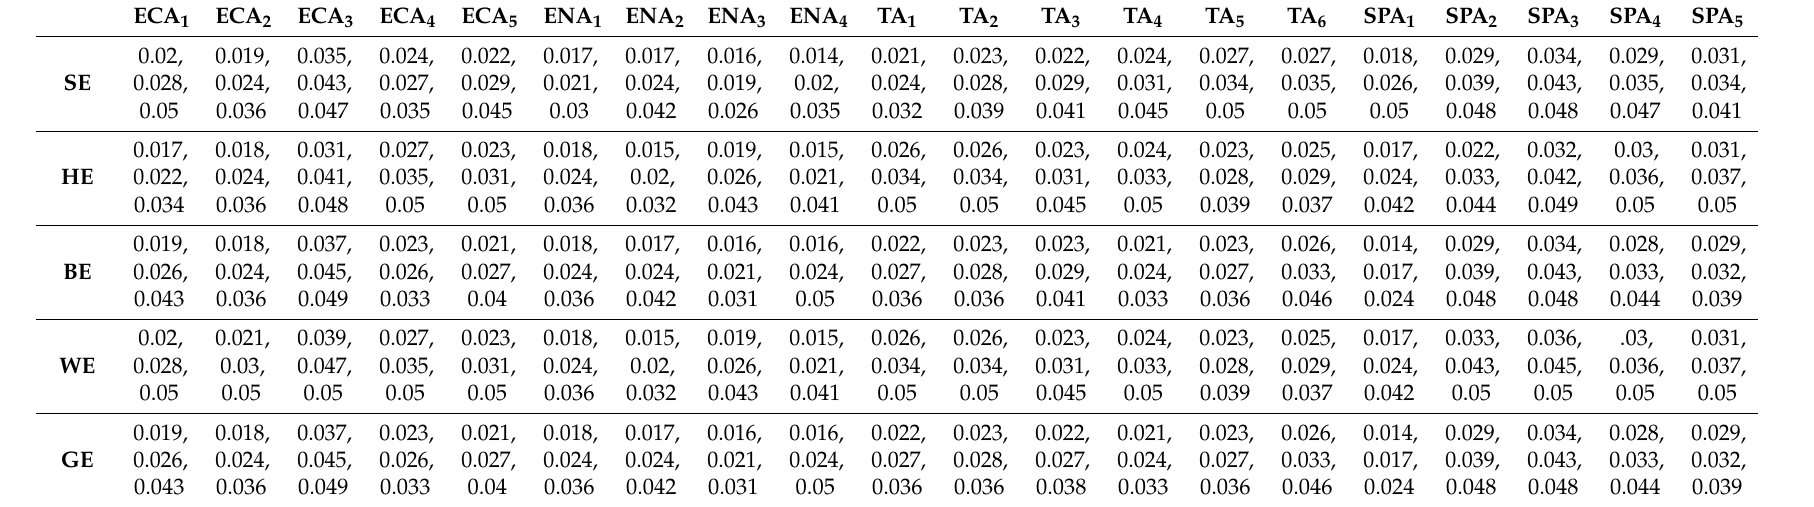
Table A10. Weighted normalized decision